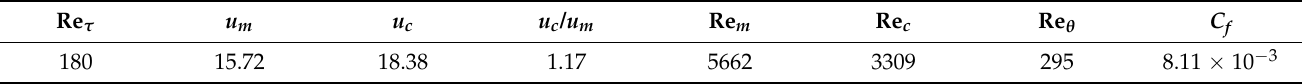
Table 3. Mean flow parameters of the DNS at a smooth